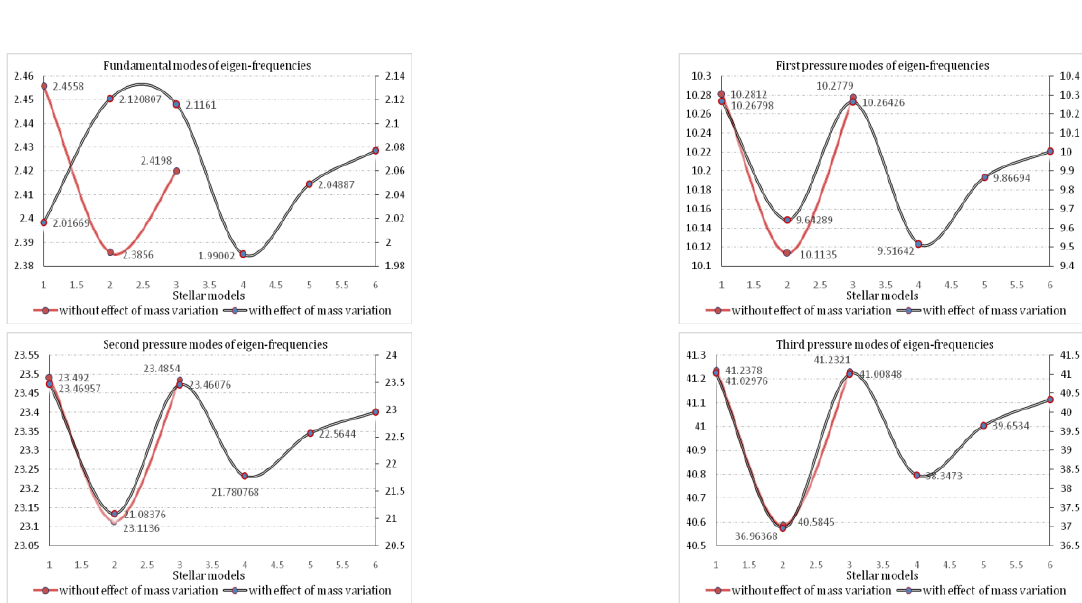
Figure 1. Eigen-frequencies of polytropic stellar models of polytropic index 1.5.